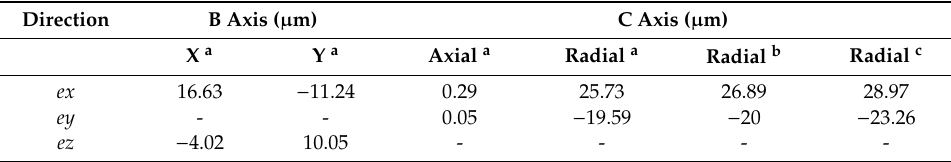
Table 6. Eccentricities of circular trajectories in numerical experiments.